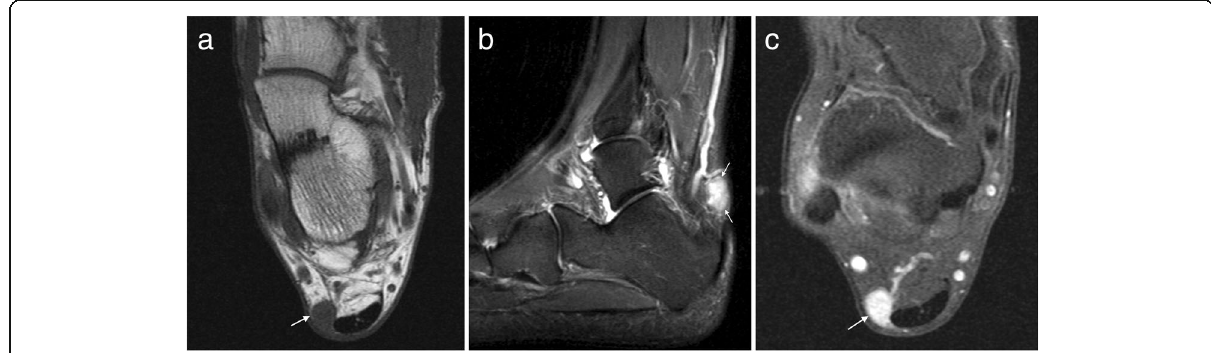
Fig. 4 Angiomyoma. Axial T1W ( a ), sagittal T2FS ( b ) and post contrast T1FS ( c ) images of the ankle showing a well-defined lesion adjacent to the Achilles tendon which appears isointense on T1W, hyperintense on T2W and avidly enhances on postcontrast imaging. Note the capsule visible on T2FS